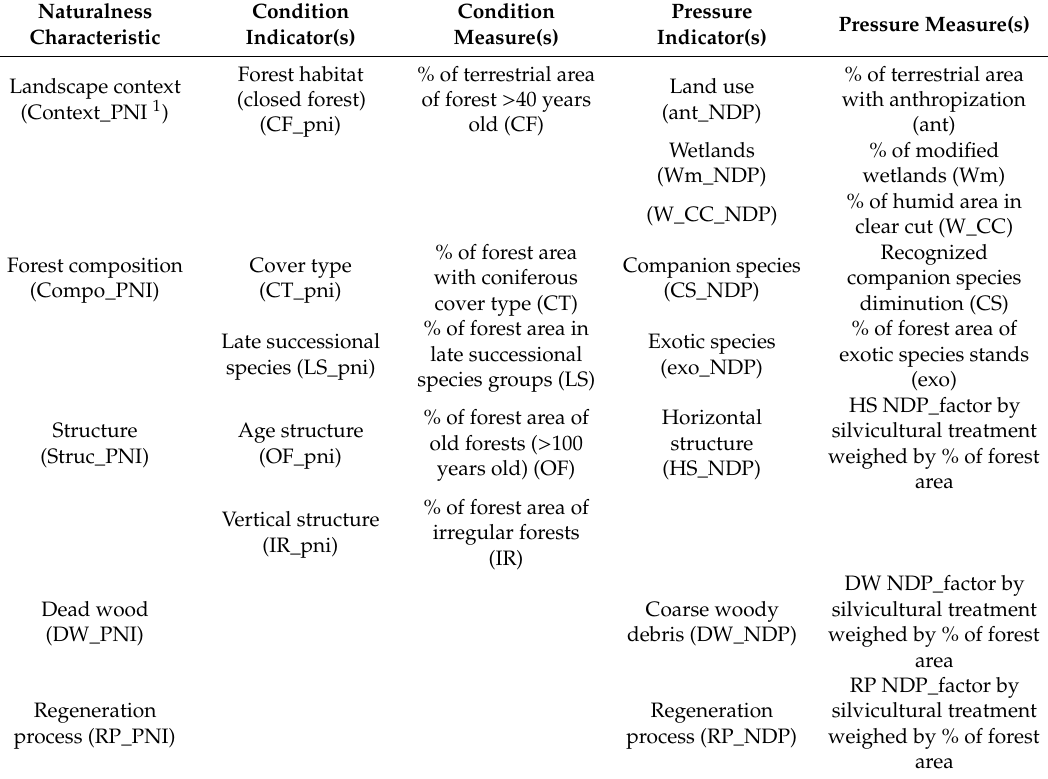
Table 1. Naturalness characteristics, indicators and